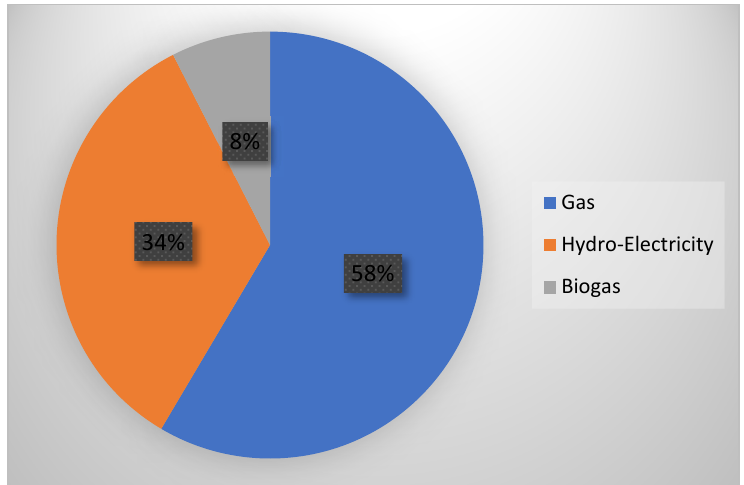
Figure 6. Frequency distribution for the preference for alternative energies (PEA).